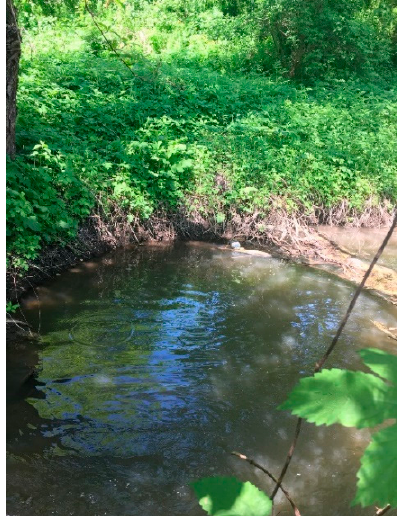
Figure 5. Biertan River refuge habitat.